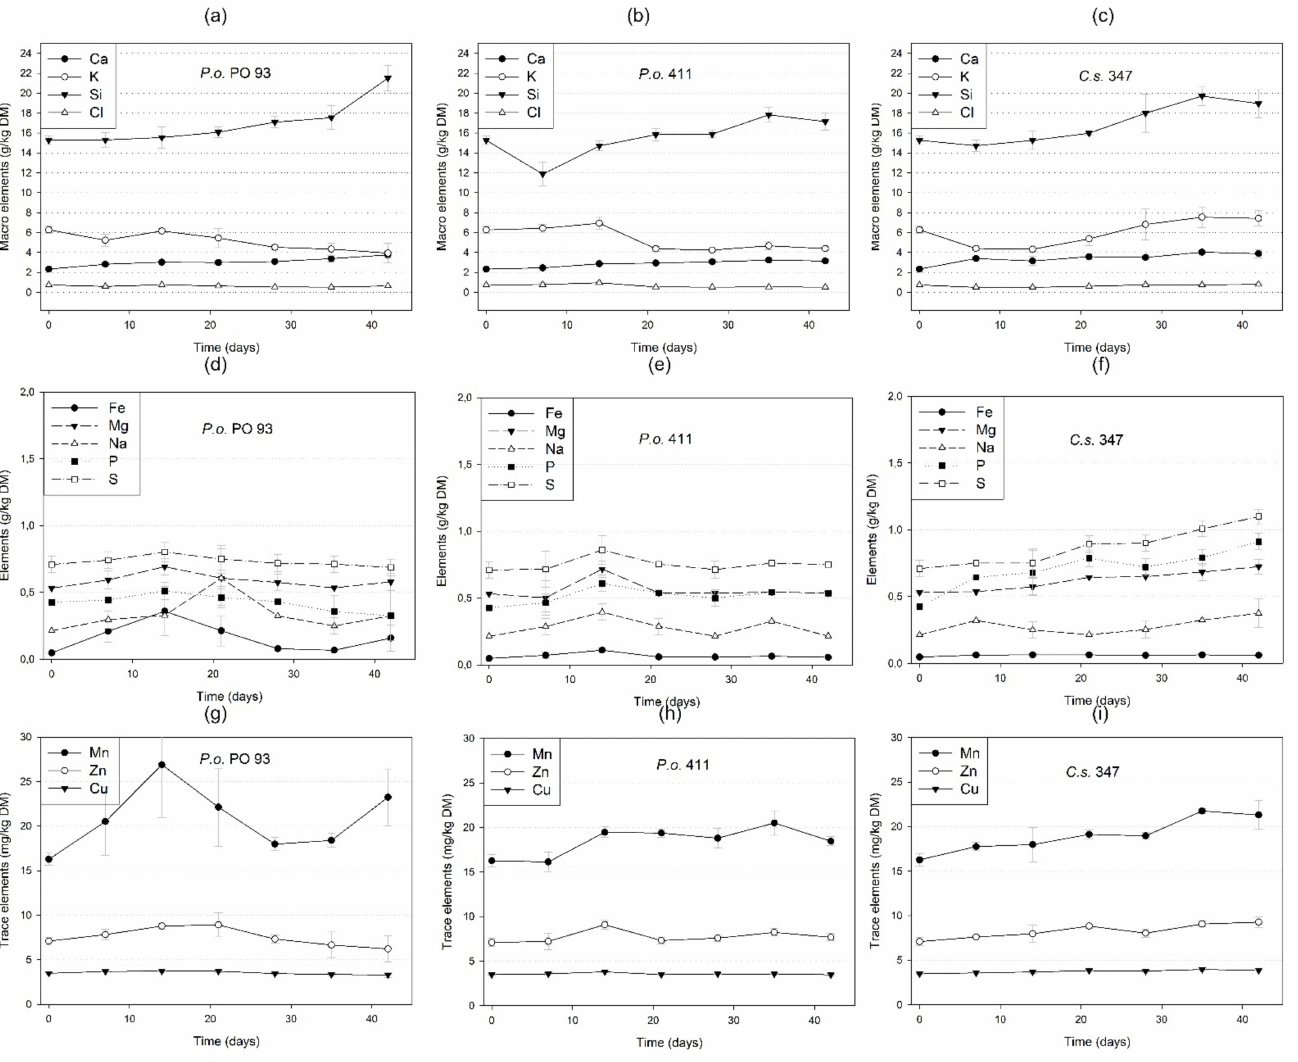
Figure 6. Macro and trace elements in fungi treated drained straw during 42 d of incubation. Left ( a , d , g ): inoculated with Pleurotus ostreatus ( P.o .) PO93, center ( b , e , h ): with Pleurotus ostreatus ( P.o. ) CBS 411.71, right ( c , f , i ): with Ceriporiopsis subvermispora ( C.s. ) CBS 347.63. First row ( a – c ): macro elements, second row ( d – f ): elements up to 2 g/kg DM, third row ( g – i ): trace elements. Error bars indicate the standard deviation